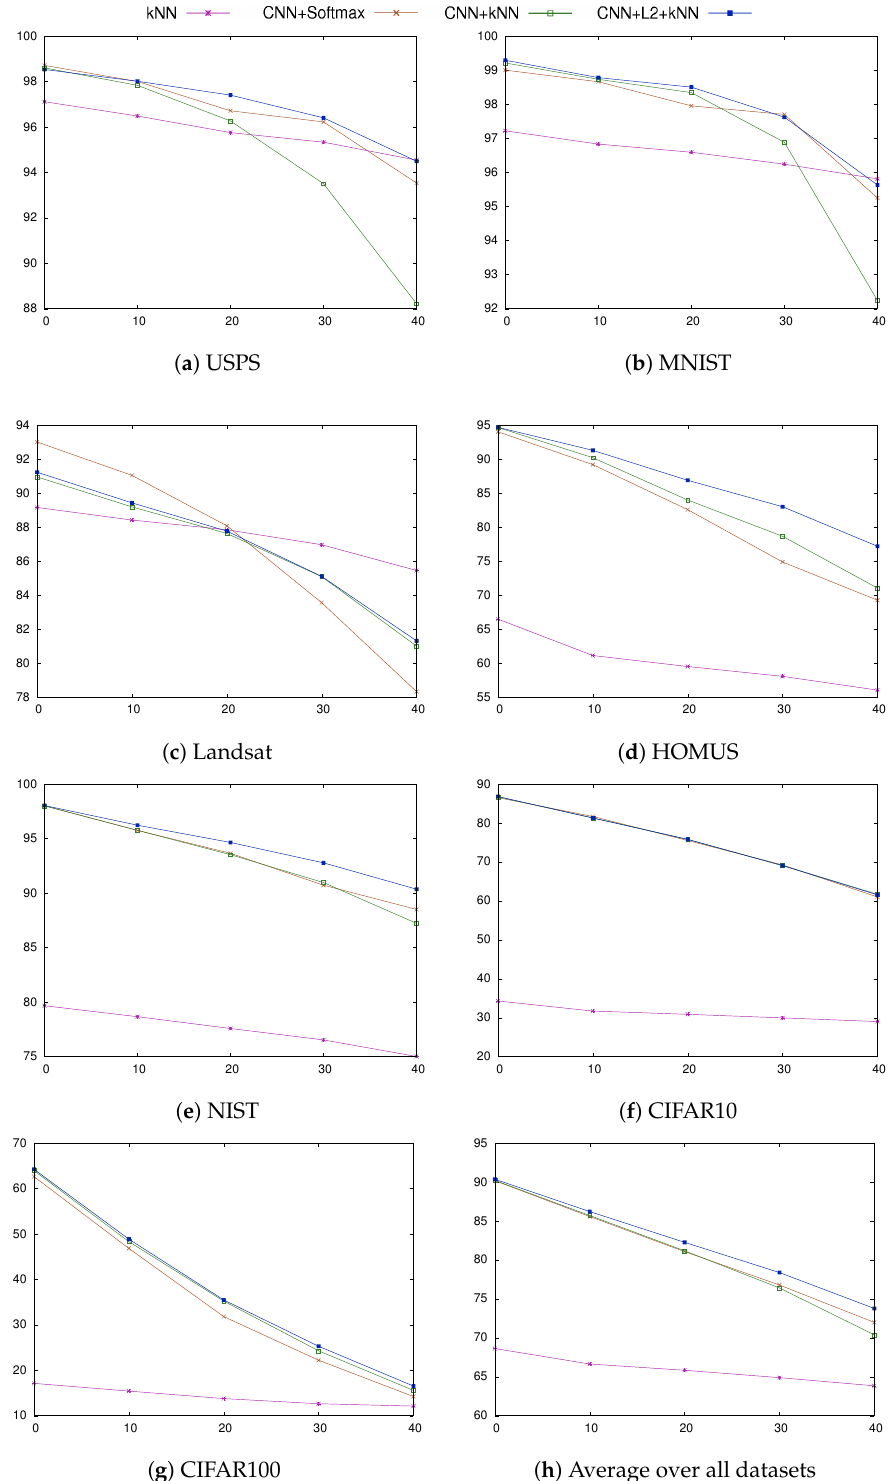
Figure 2. F 1 (%) accuracy ( y -axis) with respect to the noise level ( x -axis) for the evaluated